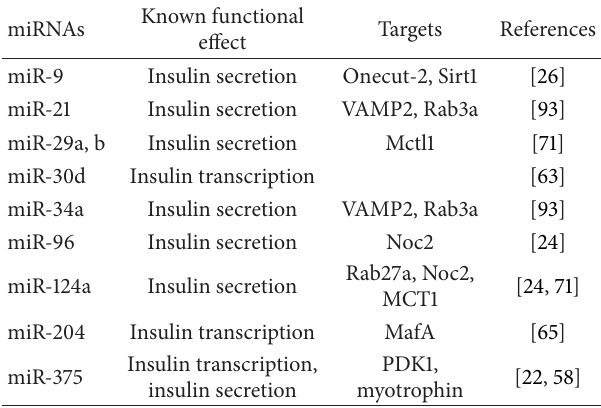
Table 2: miRNAs regulating nutrient-induced insulin secretion and insulin gene